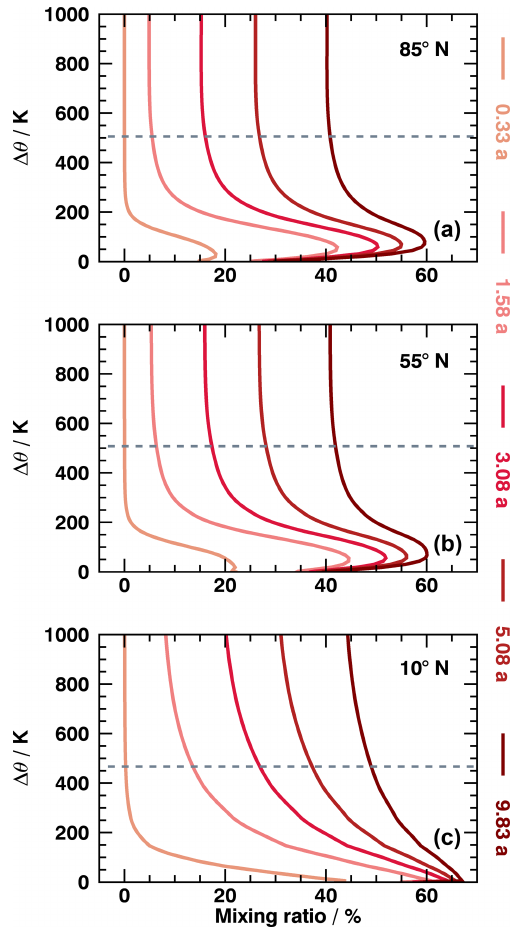
Figure 3. Vertical profiles of five radioactive trace gases at 85 ◦ N (a) , 55 ◦ N (b) and 10 ◦ N (c) as a function of potential tem- perature above tropopause. Lifetimes of species are colored. Dashed horizontal line marks the 10hPa